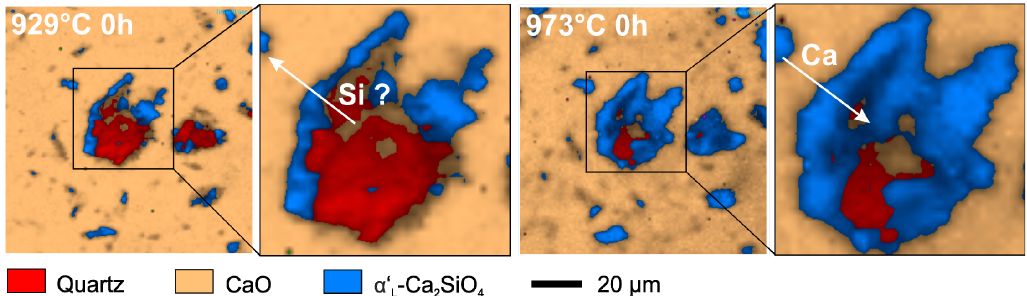
Figure 16. Hyperspectral Raman images from a sintering experiment with quartz and lime (CaO), showing grain boundary migration during the solid-state reaction between both reactants. Above 884 ± 5 °C the dicalcium silicate α ’ L -Ca 2 SiO 4 formed by the direct reaction between lime and quartz as seen in the image taken at 929 ± 5°C. At the beginning of the reaction, dicalcium silicate rims seem to have grown around the quartz grains, whereas with increasing temperature (and time) the reaction direction turned over and the dicalcium silicate replaced the quartz grain.